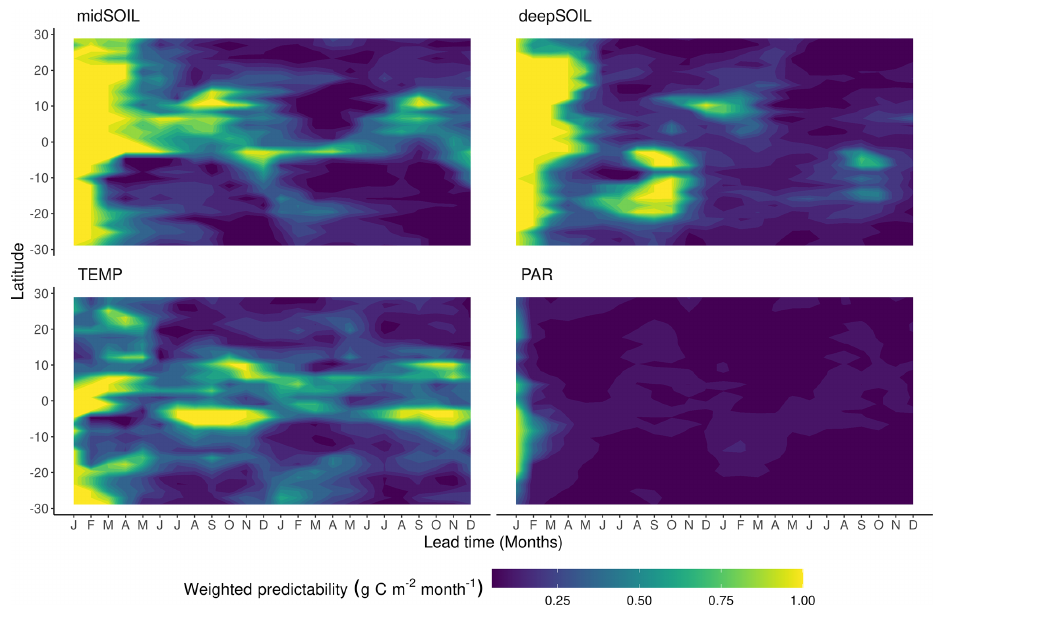
Figure 5. Zonal means of contributing components to the weighted NPP predictability ( wV c ). The contributing components are the pre- dictability of soil moisture at 19–78 and 79–268cm depth (midSOIL and deepSOIL), air temperature (TEMP), and photosynthetically active radiation